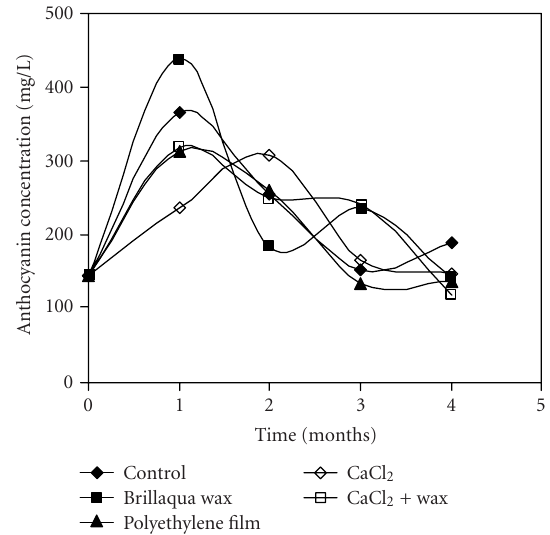
Figure 1. Evolution of total anthocyanin concentration in juice of the “Assaria” pomegranate fruits, during storage at 5 ◦ C, quan- tified by comparison with an external standard of cyanidin 3- rutinoside (Apin Chemicals, UK). Total amount of anthocyanins in the samples was calculated as the sum of the mean of individ- ual pigments.